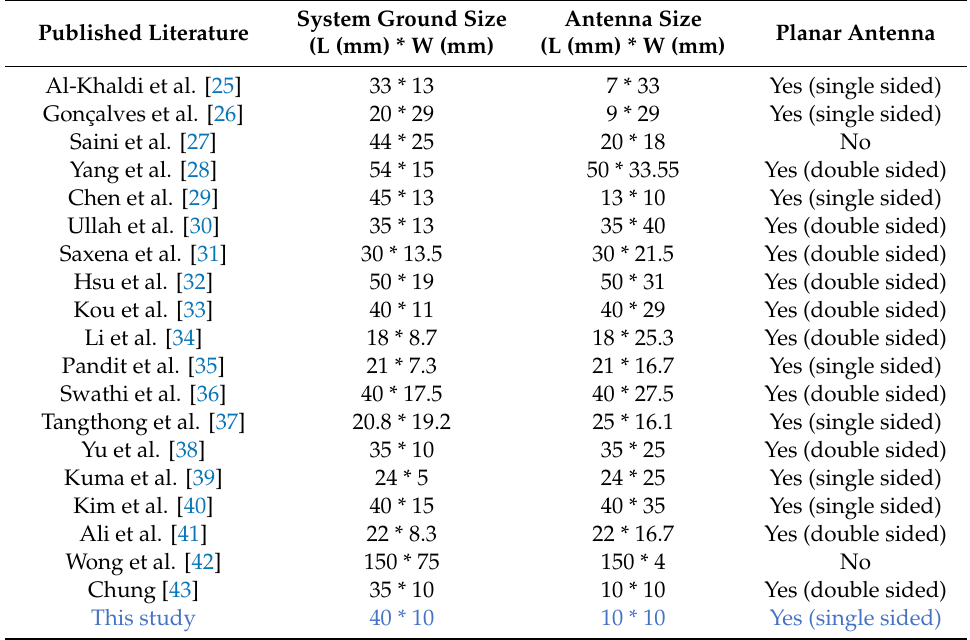
Table 2. Comparison of the proposed antenna with previously proposed antennas in terms of system ground size and antenna